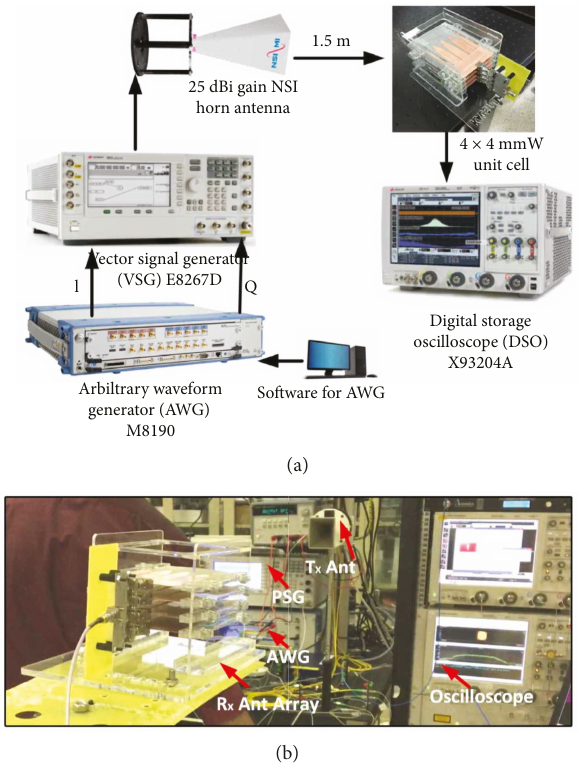
Figure 16: The proposed experimental setup. (a) Block diagram. (b) Measurements.